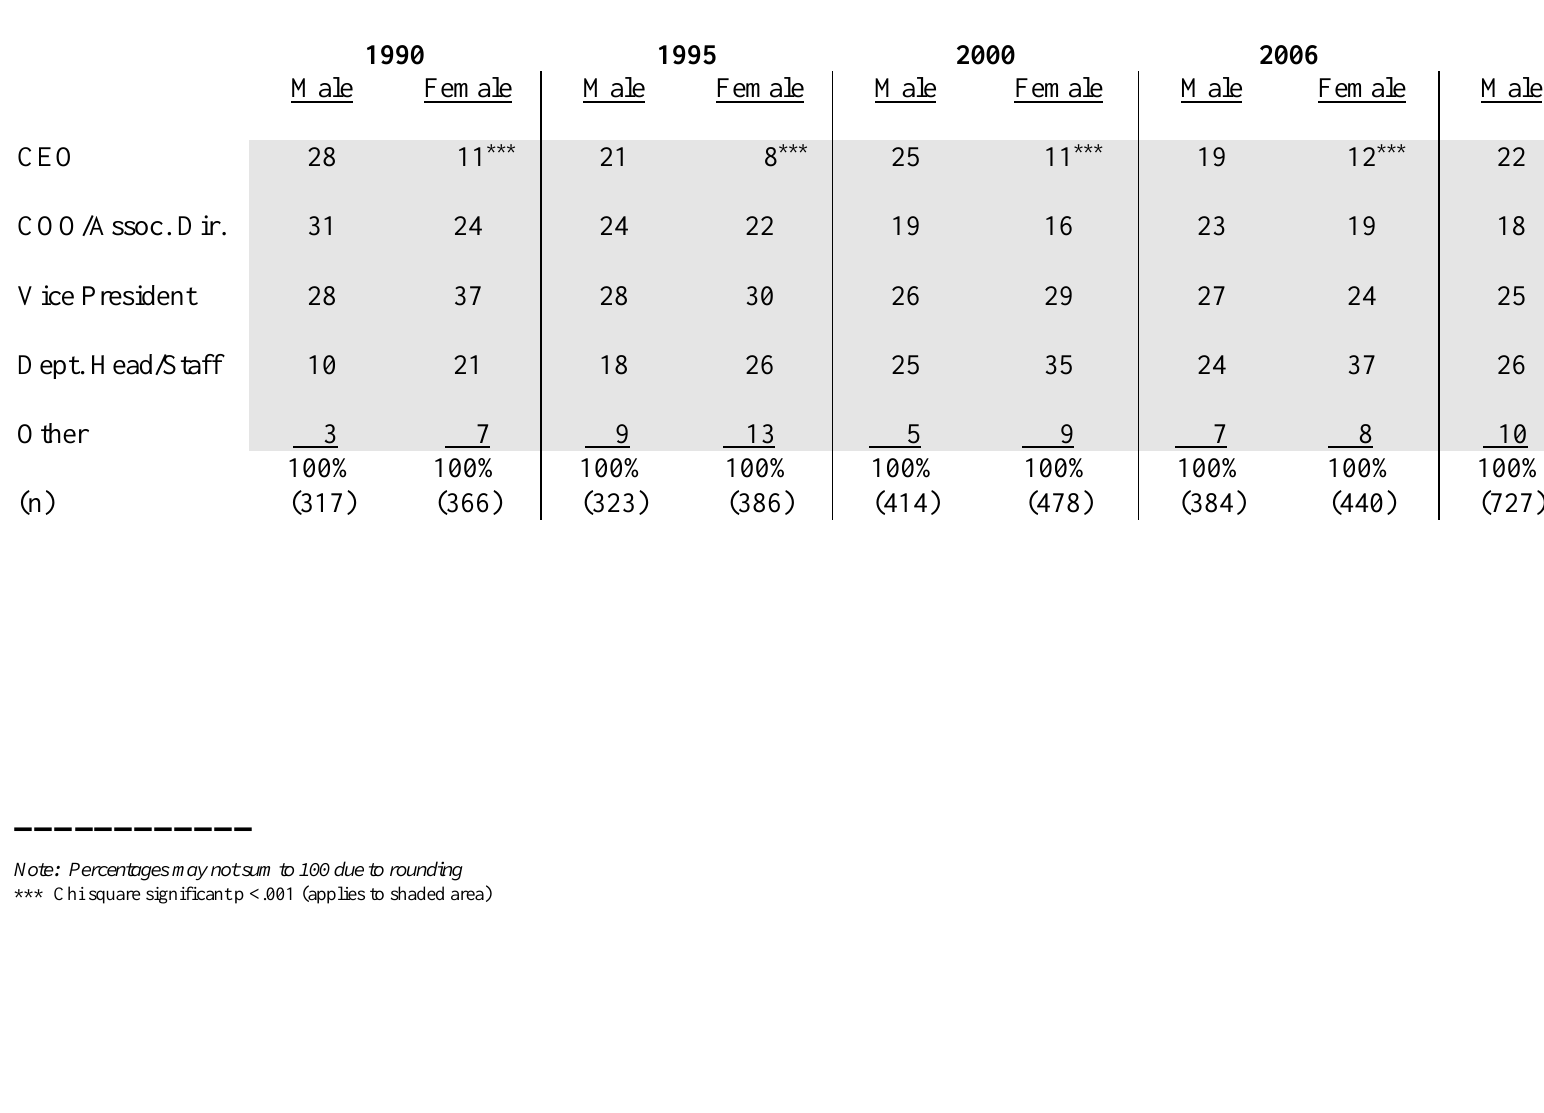
Table 2. Position by Gender and Year